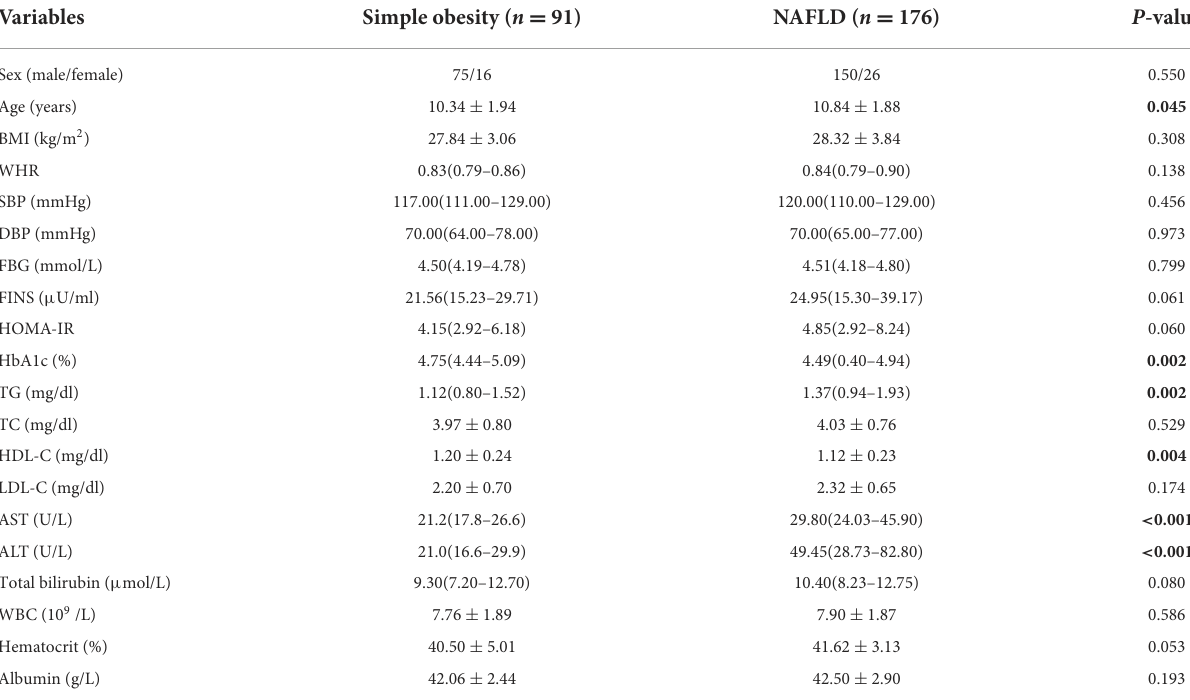
TABLE 1 Demographics and clinical characteristics of study participants.